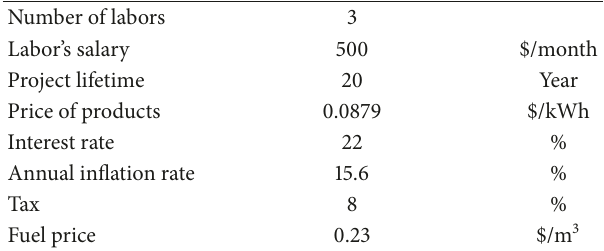
Table 7: Economic parameter.